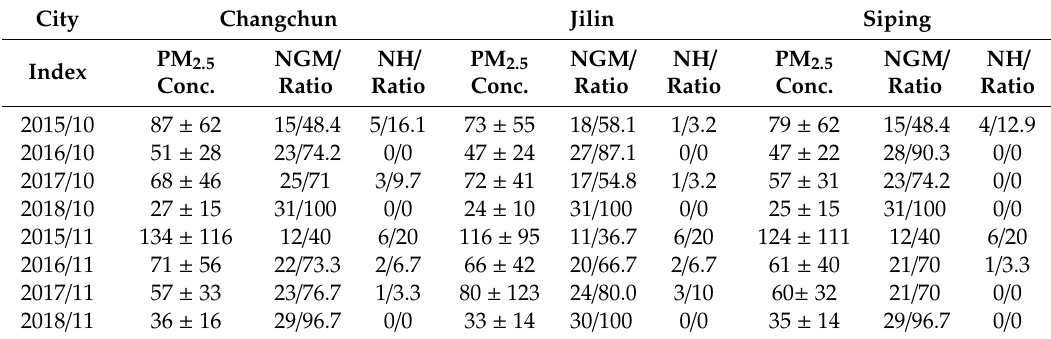
200). Ratio: the ratios of NGM or NH to the whole month. The unit of ratio is in %.